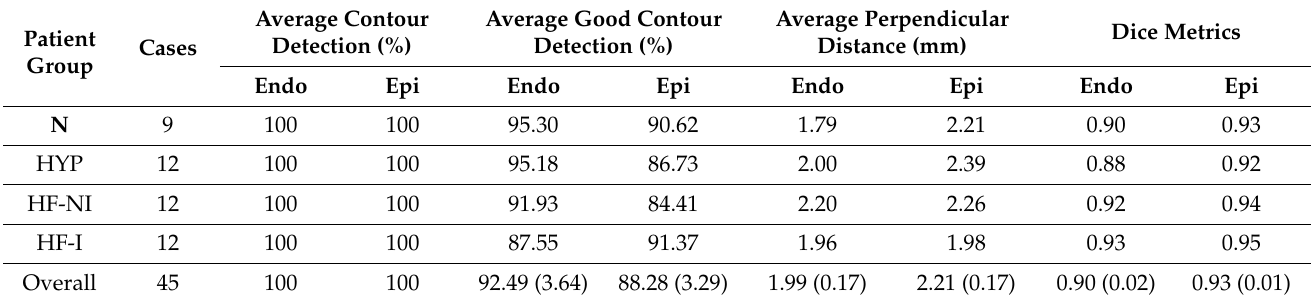
Table 16. Performance evaluation parameters for log-cosh dice loss and Relu activation.